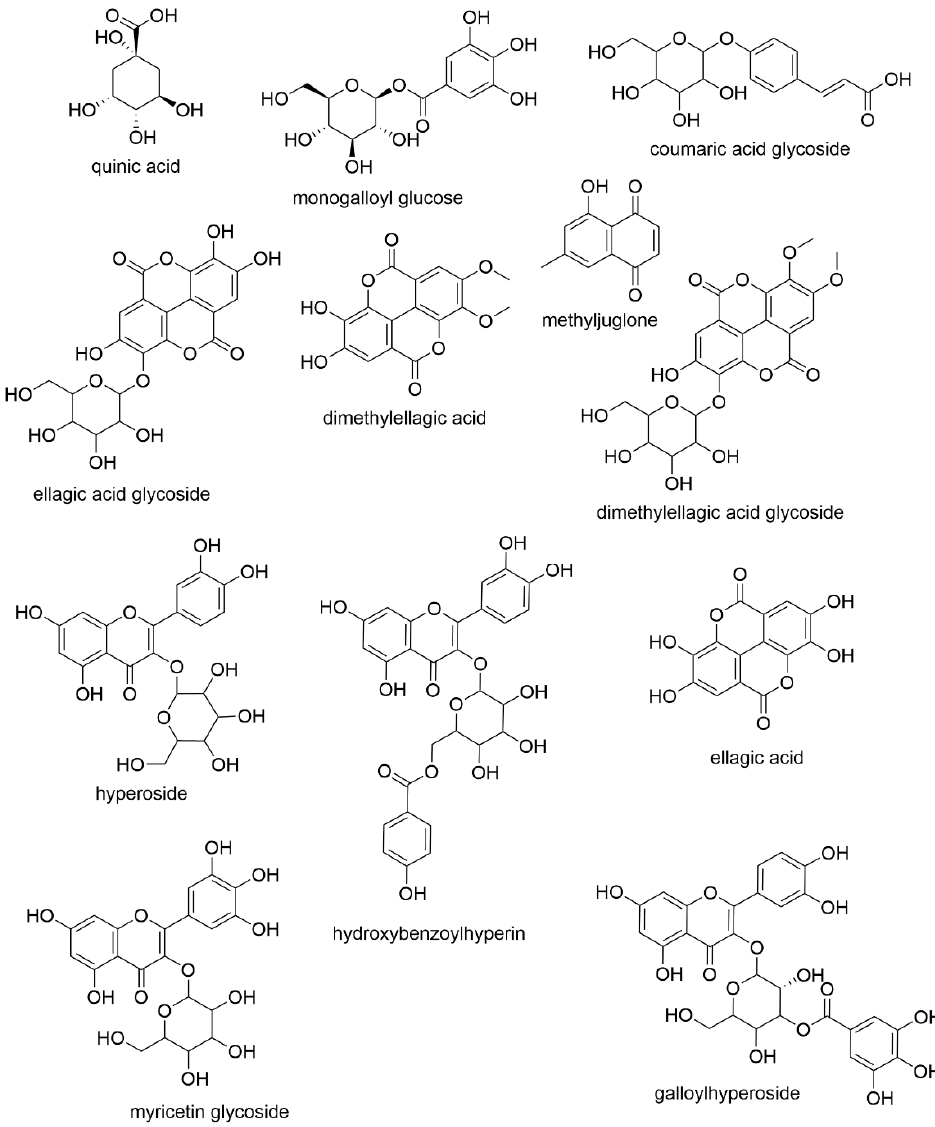
Figure 7. The compounds identified in both field-grown and lab-grown sundew ethanol extracts apart from two methyljuglone glycosides. The positions of the galloyl, benzoyl, and hexose groups are only indicative and could be any free OH-group in the structure.